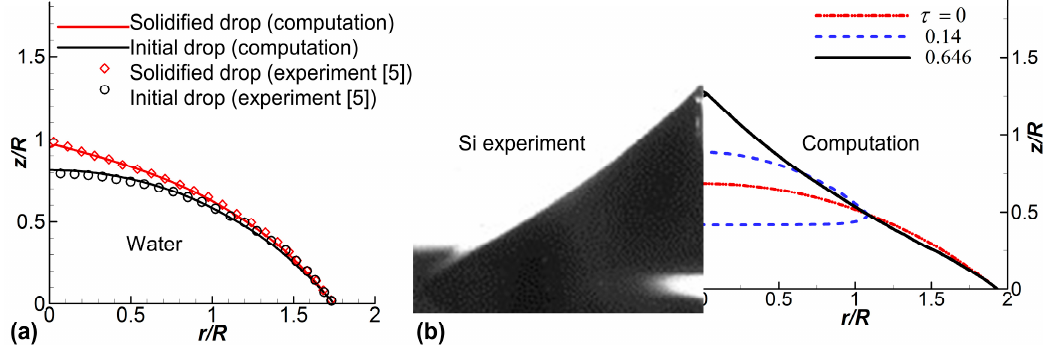
Figure 2. ( a ) Comparison of the predicted profiles (solid line) with the experimental ones [5] for a water drop ρ sl = 0.9 and φ gr = 0°; ( b ) Comparison of the predicted profile (right) with the experimental one of Satunkin [10] (left) for a Si drop with ρ sl = 0.92 and φ gr = 12° (the solid line on the right is the drop shape after complete solidification, and the figure is taken from [27]).